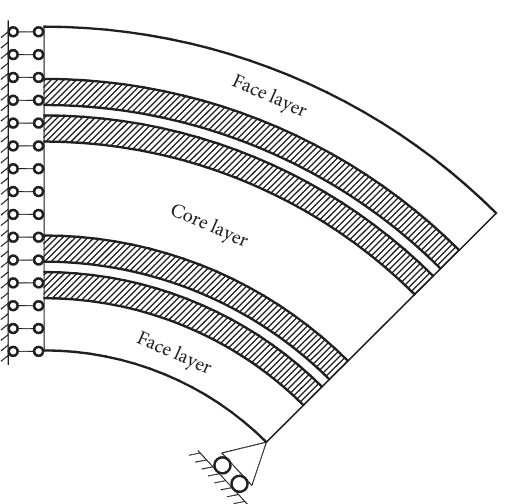
Figure 3: Schematic of the half part in the FE modeling.